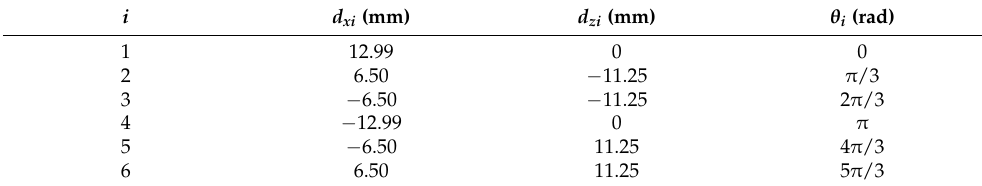
Table 2. Detailed parameters of matrix T i